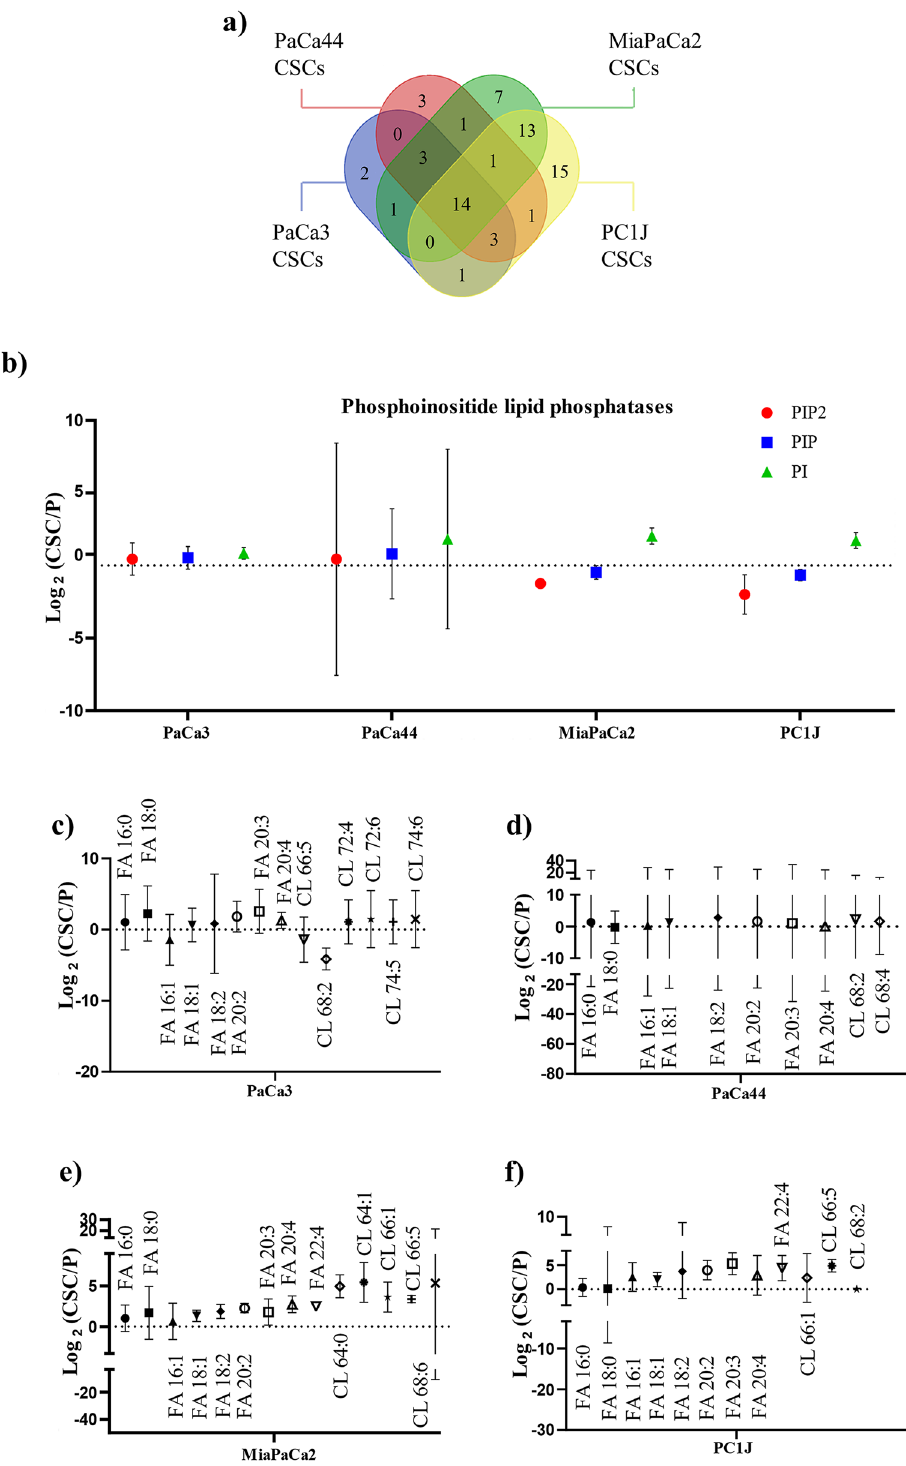
Figure 4. Increased levels of phosphatidylinositol, fatty acids and cardiolipin molecular species characterize PCSCs. ( a ) Venn diagram representation of genes implicate in active lipid pathways found using BioPAN. ( b ) Log 2 ratio (PCSC/P) in the four PDAC cell lines of the values of phosphatidylinositol diphosphate (PIP2), phosphatidylinositol monophosphate (PIP), and phosphatidylinositol (PI). Log 2 ratio (PCSC/P) in ( c ) PaCa3, ( d ) PaCa44, ( e ) MiaPaCa2, and ( f ) PC1J cells of the FA substrates and products catalysed by Elovl5, including FA 16:0 and CL molecular species remodelled by HADHA enzyme. Bars show mean fold change ± 95% confidence